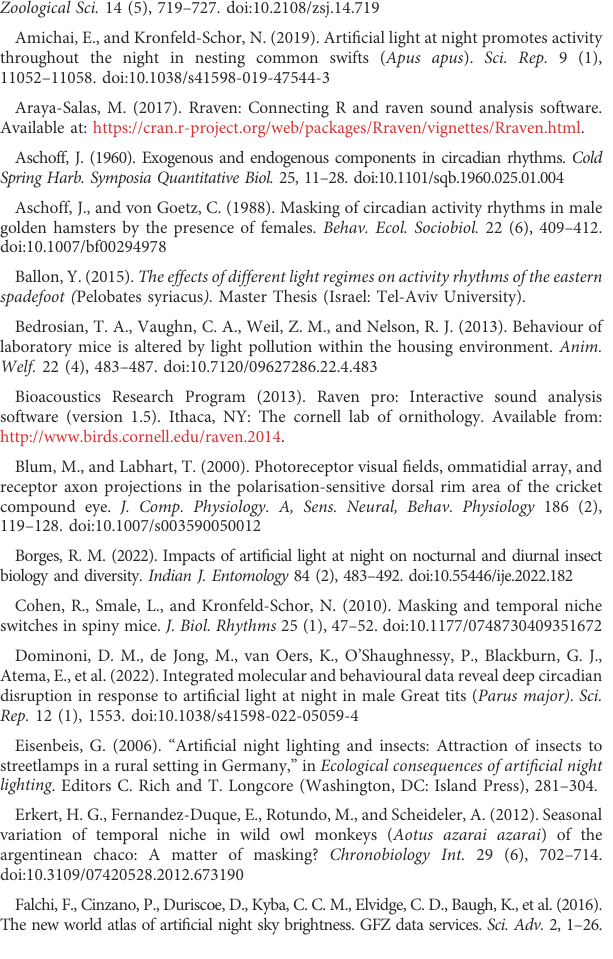
SUPPLEMENTARY FIGURE S1 Spectrograms of the light bulb used in the anechoic chamber for all experimentalgroups(LD,LA2,LA5,andLL). (A) 40lux, (B) 5lux, (C) 2lux.The light spectra were recorded using the Sekonic Sprectromaster C-700 (North White Plans, NY, United States). https://doi.org/10.6084/m9. fi gshare. 22060328.v1 for the code for the actograms Levy, Keren (2023): Actogram two behaviors code. fi gshare. Journal